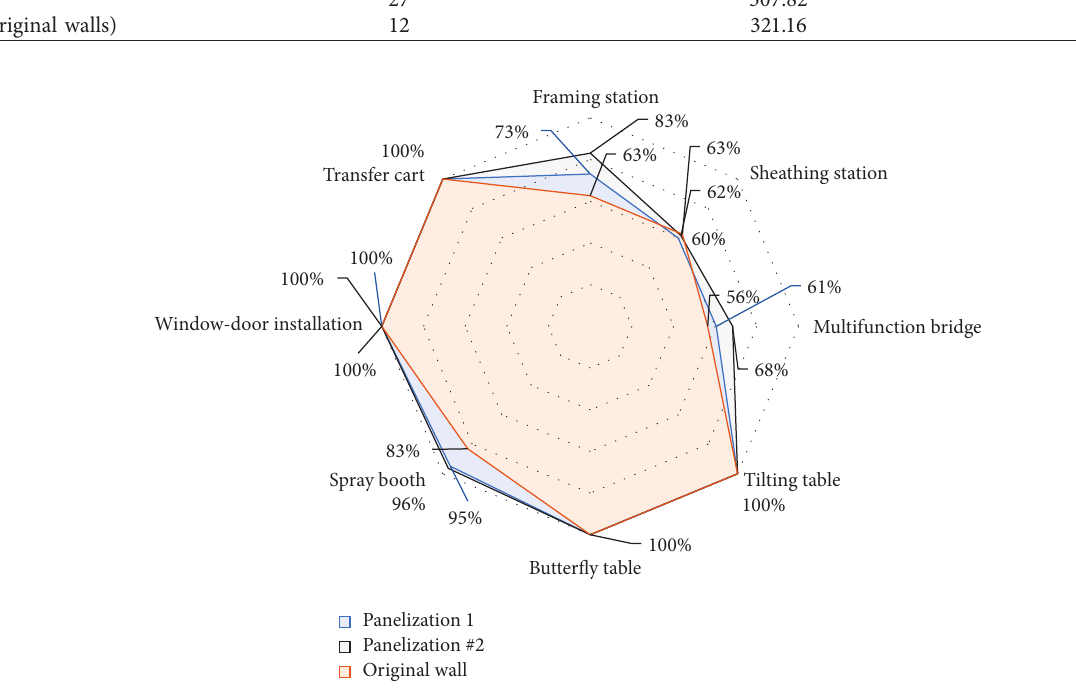
Figure 9: Workstation